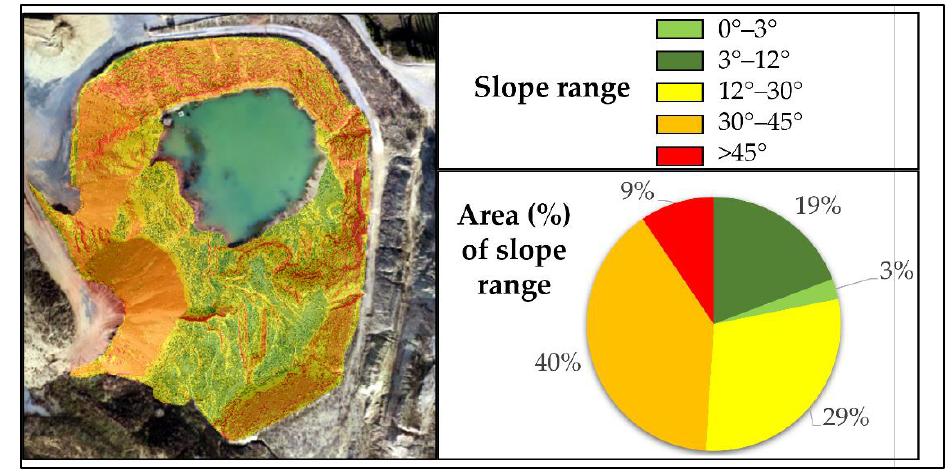
Figure 8. DEM T1 slopes analysis at the Area of Interest (AOI) (water is not computed). To analyze the relationship between the eroded area and the slope of the land, the eroded area calculation was performed for each slope category at pixel scale (Table 1). Table 1. Area eroded by range of slopes.